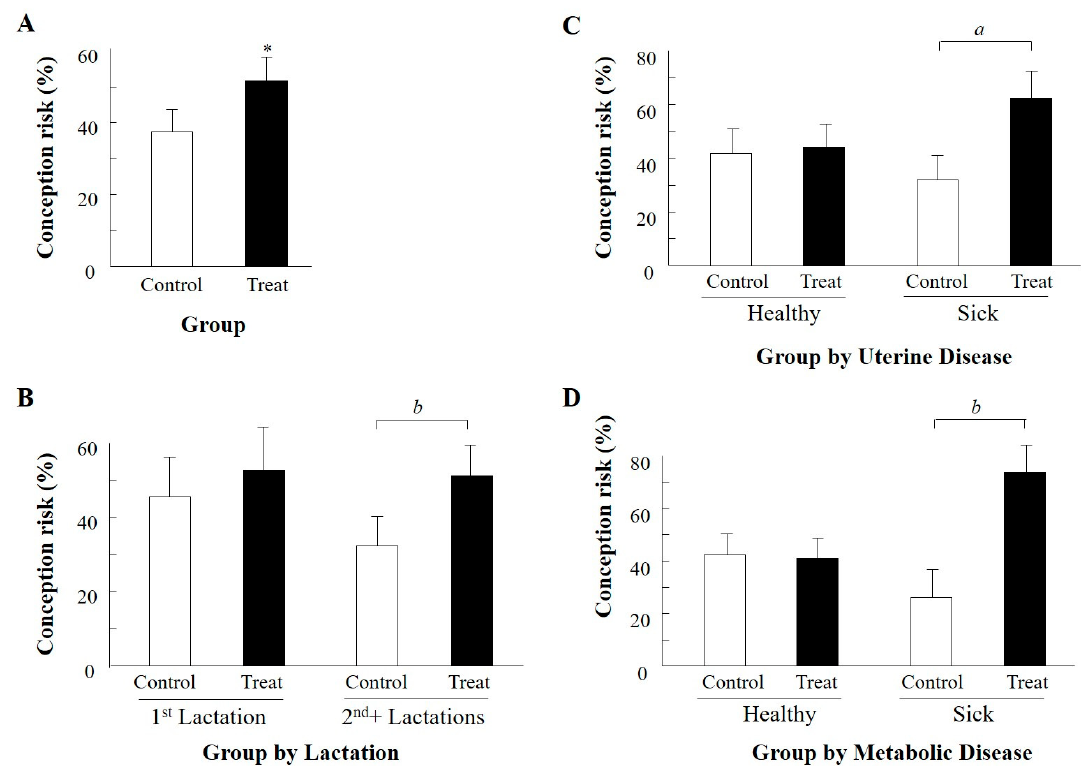
Figure 1. Effect of GnRH analogue administered within 5 h of onset of estrus (OE) on mean actual conception risks of control relative to treatment groups during the autumn only. ( A ) = main effect group, treatment vs. control; ( B ) = group by parity interaction, 1 st vs. 2+ lactations; ( C ) = group by uterine disease interaction, healthy vs. sick groups; ( D ) = group by metabolic disease interaction, healthy vs. sick groups. Interactions with a tendency toward significance are presented. Numbers of AI are presented in Table 4. Data are mean ± SEM. Treat = treatment. * p < 0.03; a p = 0.07; b p =